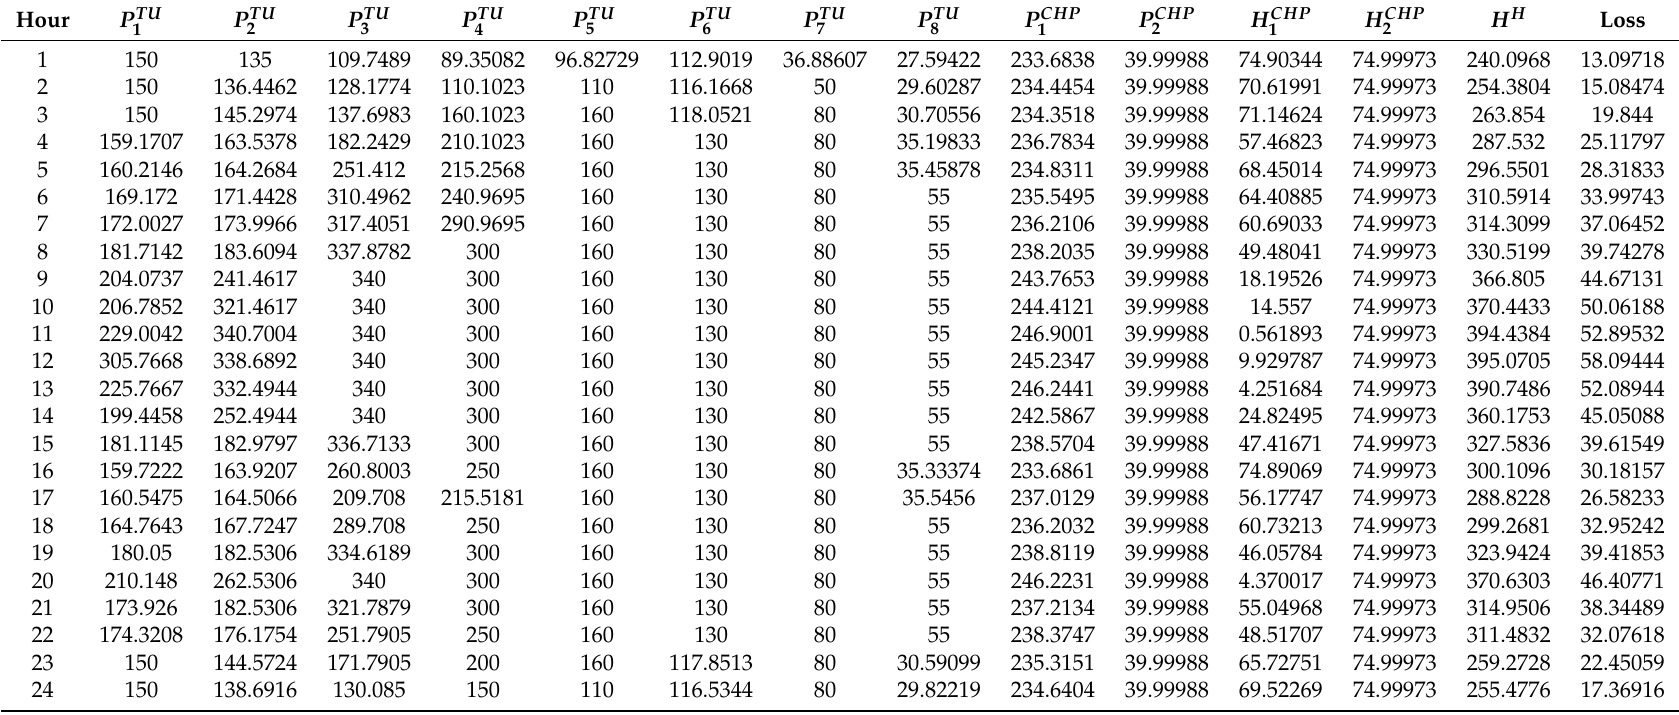
Table A1. Detailed power flow results for Case